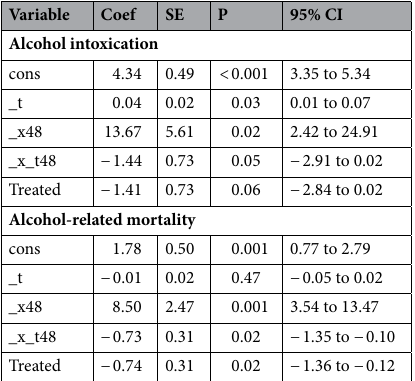
Table 3. Interrupted time series analysis comparing level, trend and mortality of alcohol intoxication in pre- COVID-19 to during COVID-19 period.